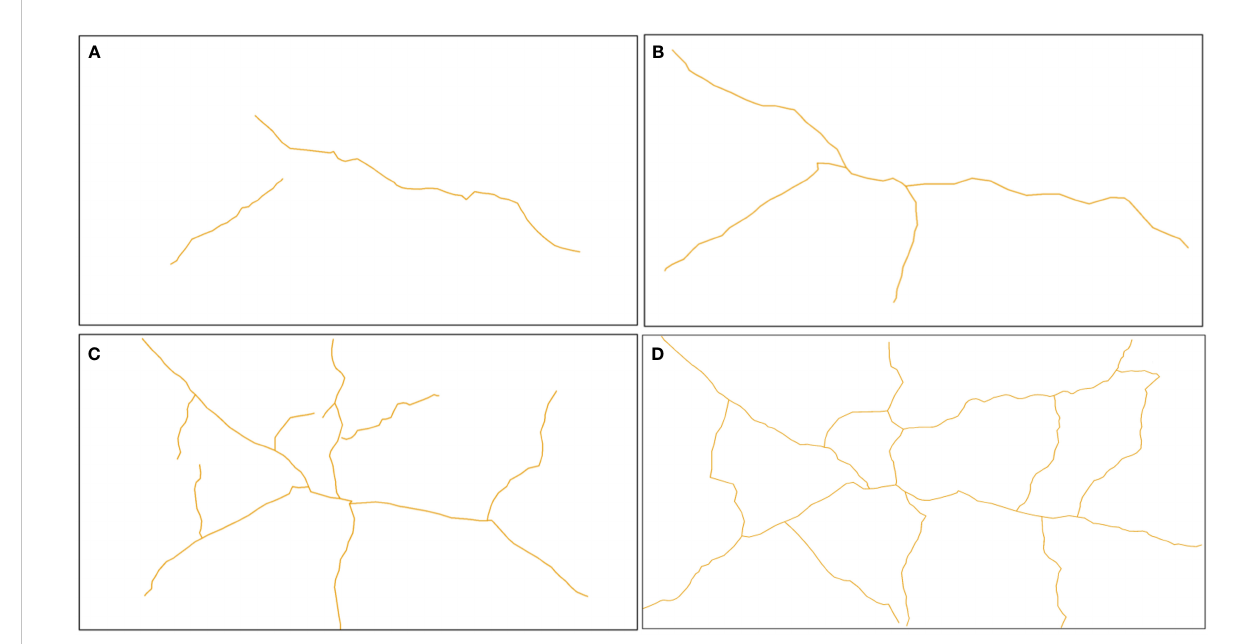
FIGURE 5 Evolution of mud cracks during the experimental period. (A) Mud cracks at the end of the second CDOE, (B) at the end of the third CDOE, (C) at the end of the fi fth CDOE, (D) and at the end of the seventh CDOE. CDOE is consecutive days of emersion.